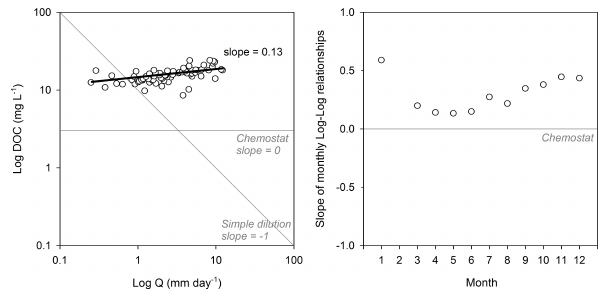
Fig. 3. Scatter plot of concentration – discharge relationship in May during 15 years in V¨astrab¨acken, plotted on a Log-Log scale (Left panel). Reference lines indicate the slopes 0 and − 1, which cor- respond to chemostatic behavior and simple dilution, respectively. The right panel displays the monthly slopes of the Log-Log concen- tration – discharge relationships. All (but February) were significant on the 0.05 level.